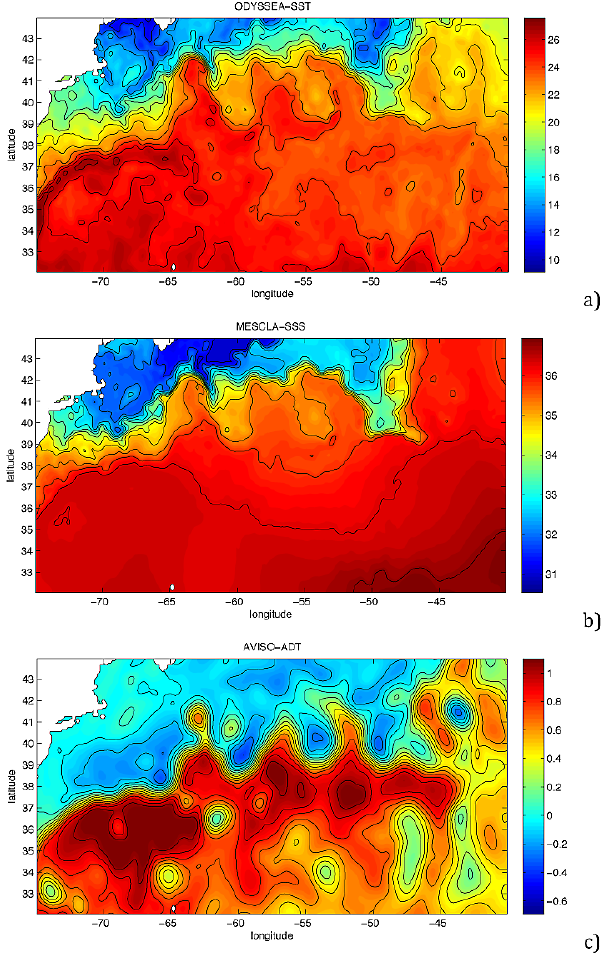
Fig. 1. (a) SST (ODYSSEA L4), (b) SSS (MESCLA HR) and (c) SSH (AVISO) over the Gulf Stream area for the 17 October